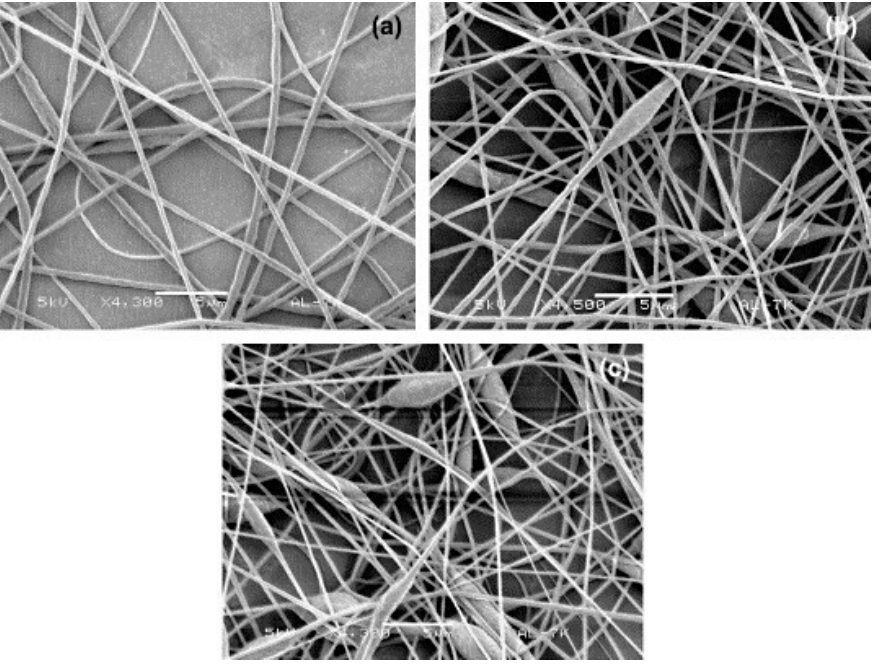
Figure 4. SEM micrographs of PVDF fibers obtained at 15 kV from 20 wt. % PVDF by electrospinning with different DMF/acetone weight ratios of: ( a ) 60/40; ( b ) 70/30; and ( c ) 80/20